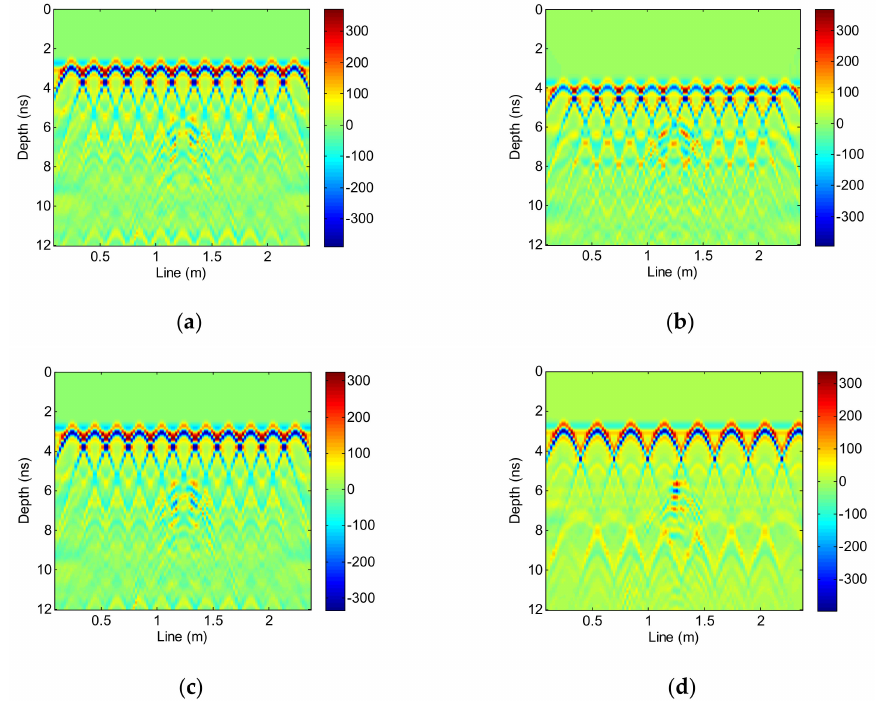
Figure 12. Input data of the trained network (unit: cm). ( a ) Depth of 10, spacing of 20, and radius of 1.25. ( b ) Depth of 15, spacing of 20, and radius of 1.25. ( c ) Depth of 10, spacing of 20, and radius of 1. ( d ) Depth of 10, spacing of 30, and radius of 1.25.